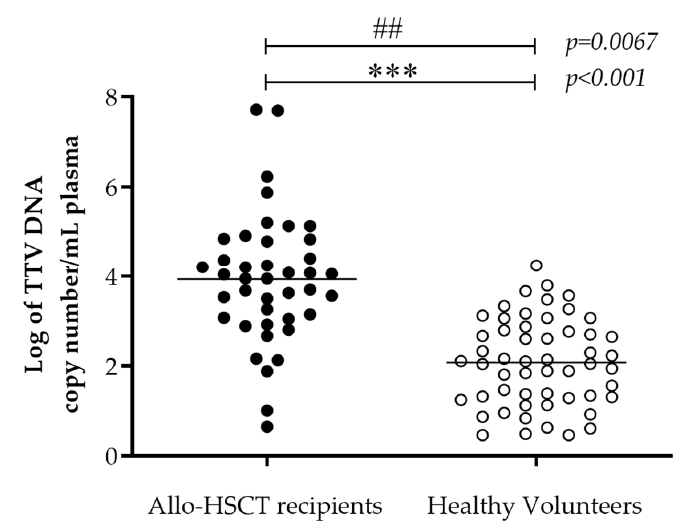
Figure 1. TTV viral load in healthy volunteers and allo-HSCT plasma samples. TTV viral load from 41 allo-HSCT recipients (black) and 54 healthy volunteers (white) plasma was quantified by